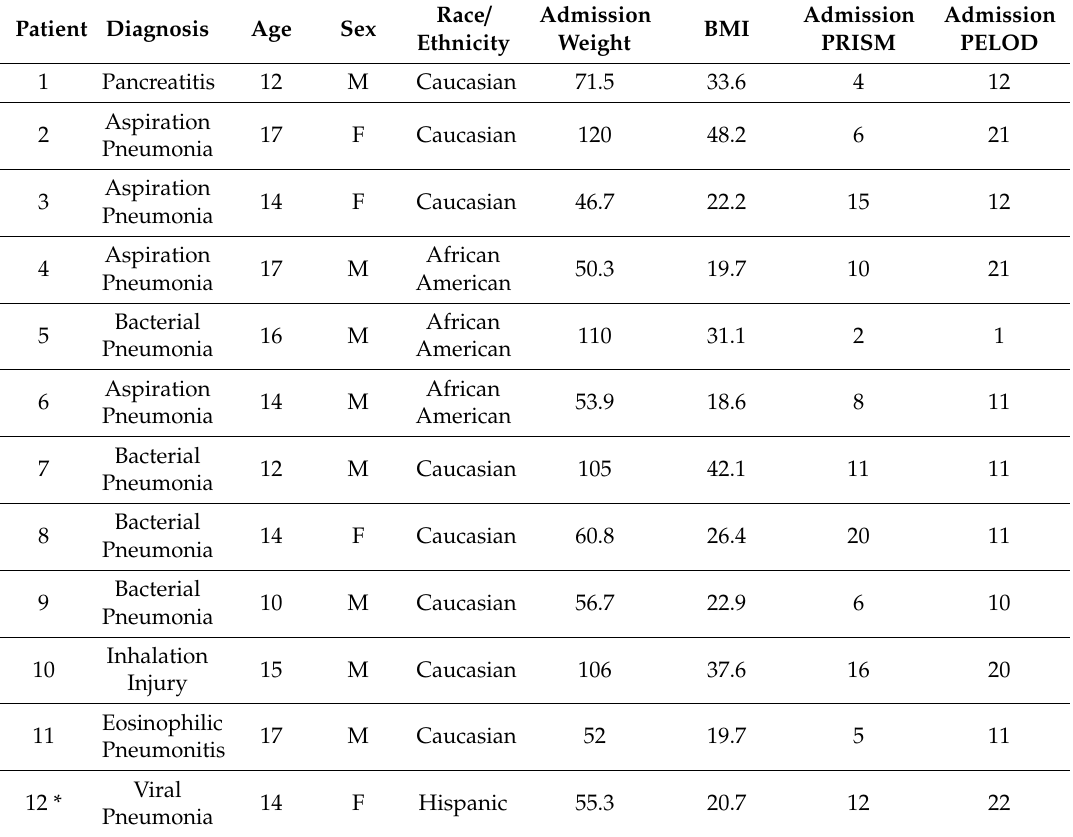
Table 1. Patient demographics for each subject included in the case